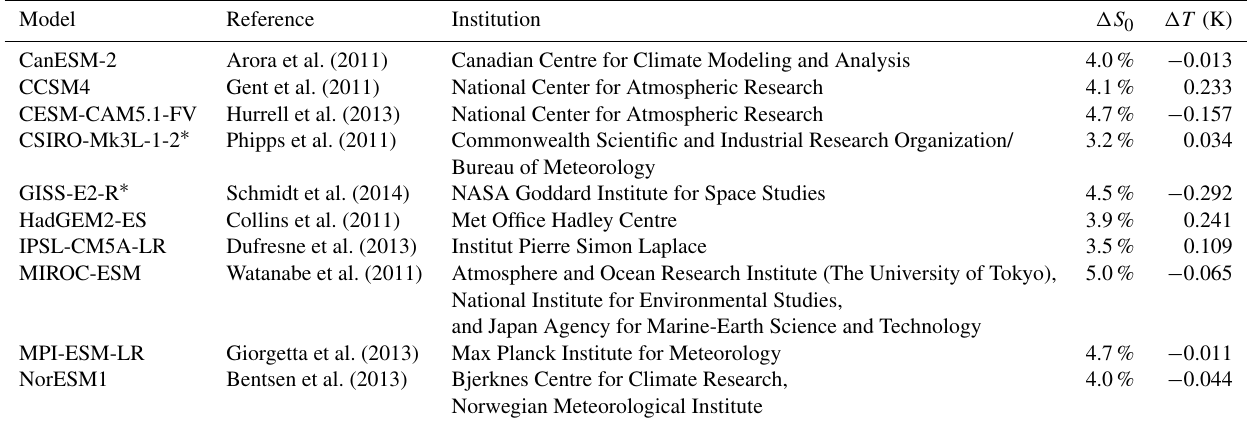
Table 1. Models included in this study, with references, institutions, solar constant reduction in the G1 experiment ( (cid:49)S 0 ), and global mean surface air temperature change in G1 – piControl ( (cid:49)T